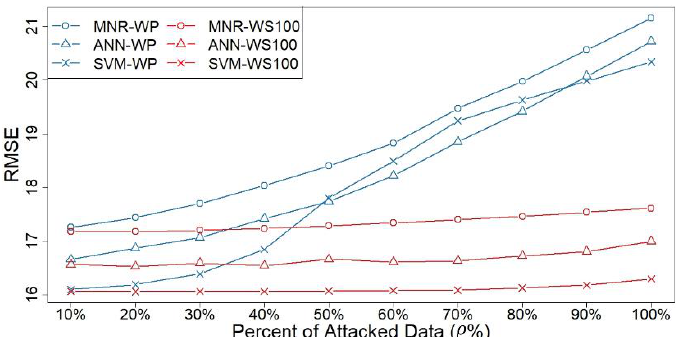
Figure 5. Root mean square error (RMSE) comparison of three deterministic forecasting models under false data attacks on output variable “WP” or input variable “WS100” .